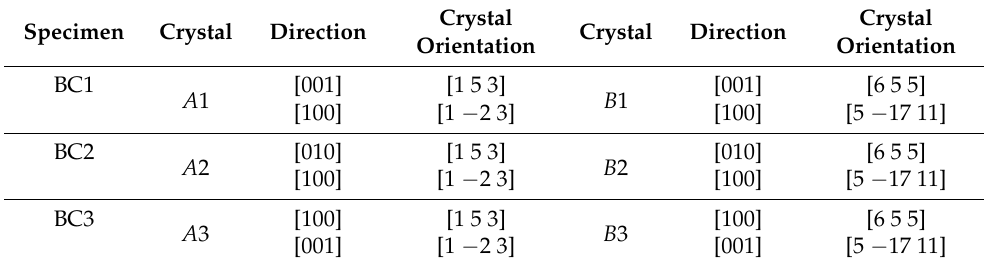
Figure 1. ( a ) Schematic of bicrystalline pillar, ( b ) engineering stress–strain curves of specimens that are used to determine the material parameters. The contours of the accumulative plastic slip on the surface of specimen BC1, ( c ) on the front side and ( d ) on the reverse side. Table 1. Crystal orientations of the three bicrystalline specimens.